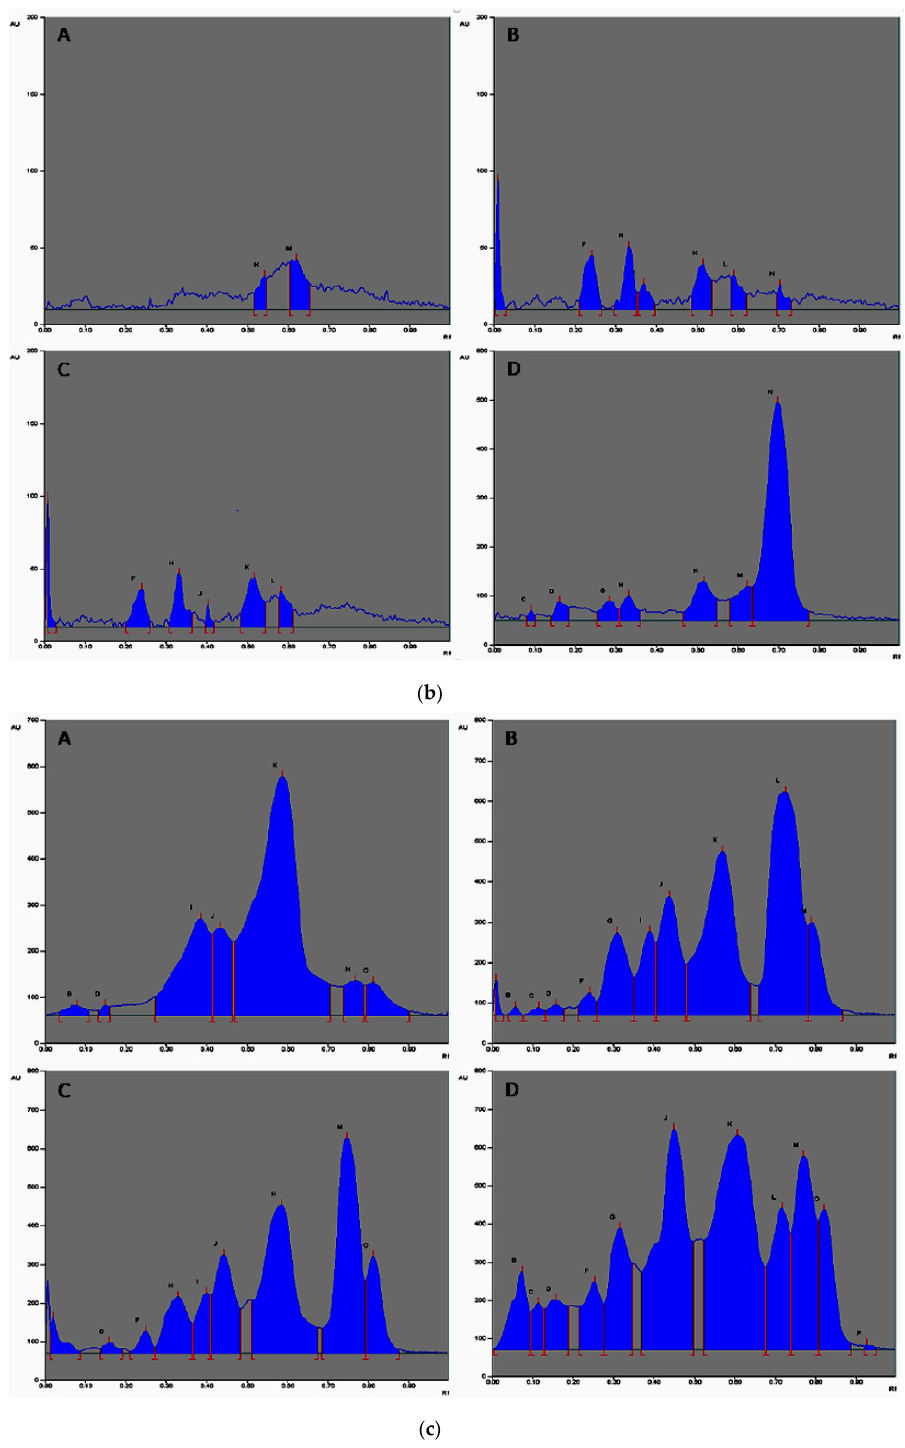
Figure 4. ( a ) HPTLC fingerprint of various essential oils of seeds of T. ammi L. extracted via diverse extraction methods. A: Hydrodistilled oil, B: Solvent extracted oil, C: Ultra sonicated oil, D: SC-CO 2 oil observed at 254 nm with assigned substance; ( b ) HPTLC fingerprint of various essential oils of seeds of T. ammi L. extracted using different extraction methods. A: Hydrodistilled oil, B: Solvent extracted oil, C: Ultra sonicated oil, D: SC-CO 2 oil observed at 366 nm with assigned substance; ( c ) HPTLC chromatograms of different oils of T. ammi L. Extracted using different extraction techniques. A: Hydrodistilled oil, B: Solvent extracted oil, C: Ultra sonication oil, D: SC-CO 2 oil visualized at 580 nm with assigned